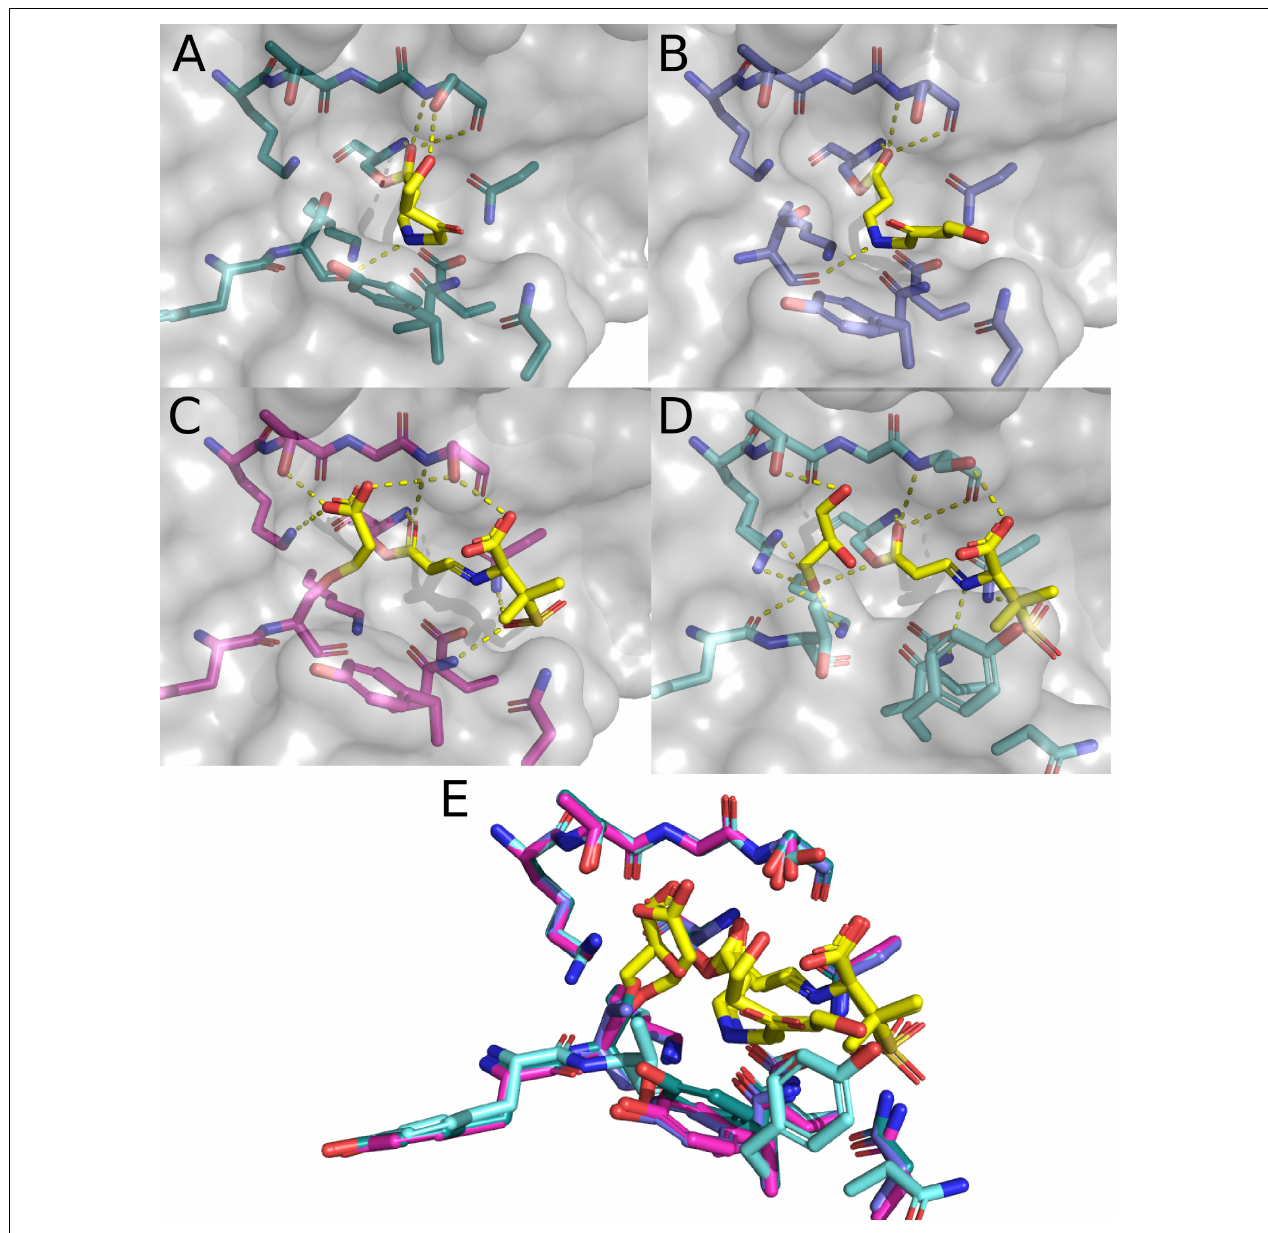
FIGURE 7 | Structure of CTX-M-15 with Sulbactam and clavulanic acid. (A) CTX-M-64 complexed with hydrolysis products of clavulanic acid (6J2O). (B) CTX-M-64 TDN mutant bound to clavulanic acid hydrolysis products (6J2K). (C) CTX-M-64 bound to sulbactam hydrolysis products (6ITY). (D) CTX-M-64 TDN mutant bound to sulbactam hydrolysis products (6J2B). (E) Overlay of the CTX-M-64 and TDN mutant structures featured in panels (A–D) .